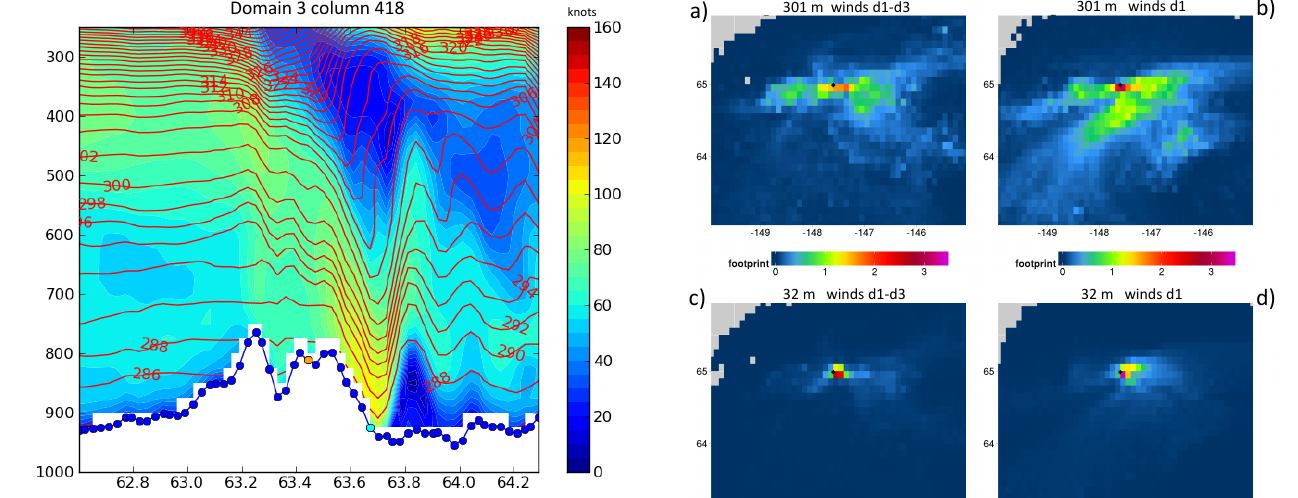
Figure 15. As in Fig. 14a, but along column 418 of domain 3. Lo- cation of cross section is denoted in Fig. 14c near 144.5 ◦ W.